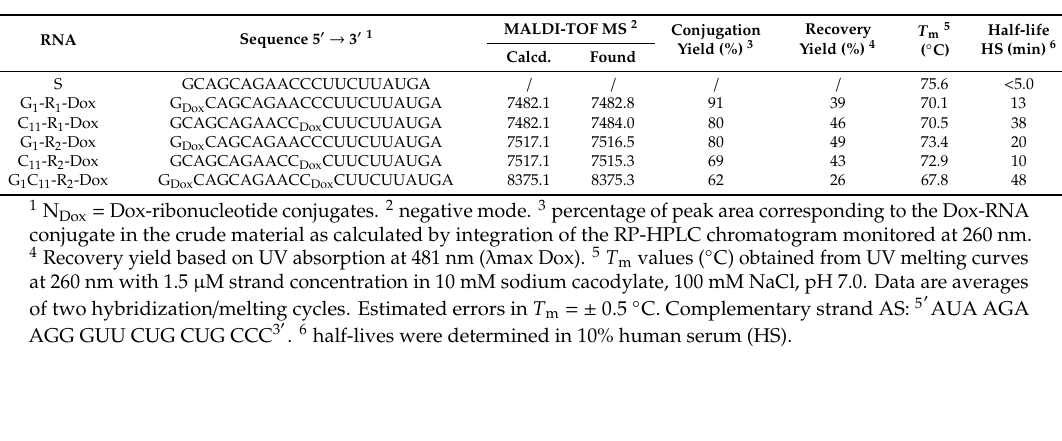
Table 2. Data on Dox-RNA